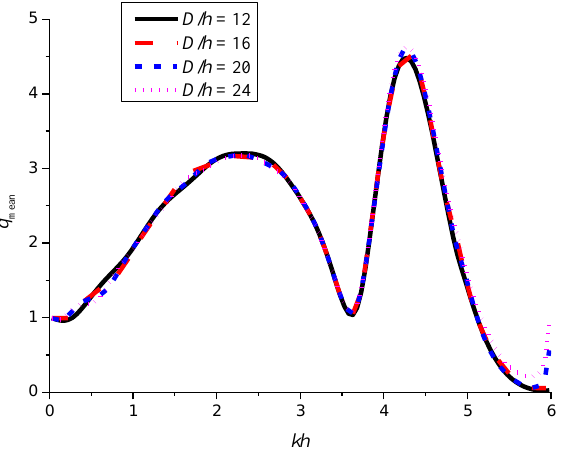
Figure 14. Variations of q mean vs. kh for the WEC array with different lengths D of the rear pontoon.